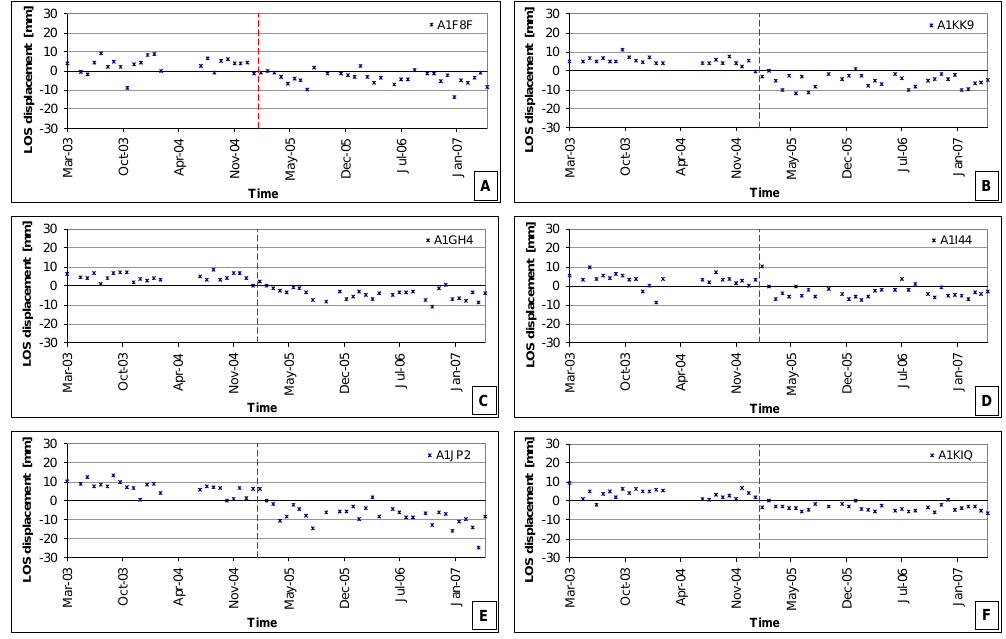
Fig. 8. Examples of LOS deformation time series (RADARSAT-1 data, 2003–2007) for the buildings of Vanelle St. and the central area of the town of Naro. Some rapid displacements (about 5–10mm) and temporary or permanent accelerations of the deformation rates (up to 40–50mmyr − 1 ), can be detected starting from the end of 2004 and up till March 2005. These movements are connected with the fracture reactivation of February 2005 (red dashed